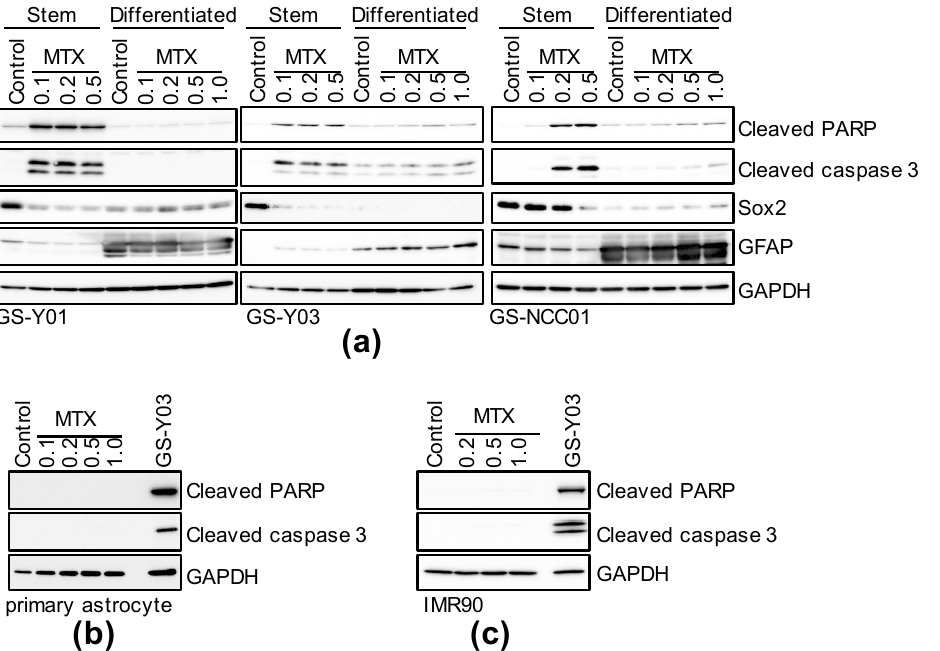
Figure 1. Methotrexate (MTX) induces cell death specifically in glioma stem cells (GSCs), but not in differentiated GSCs. GSCs (GS-Y01, GS-Y03, and GS-NCC01) and differentiated GSCs (dGS-Y01, dGS-Y03, and dGS-NCC01) ( a ), mouse astrocytes ( b ), and IMR90 cells ( c ) treated with the indicated concentrations of methotrexate (MTX) or control solvent treatment for 3 days were analyzed by propidium iodide incorporation assay. Similar results were obtained from two independent biological replicates. Data are presented as means + standard deviation. * p < 0.05 vs. control-treated cells by the Mann–Whitney U test.